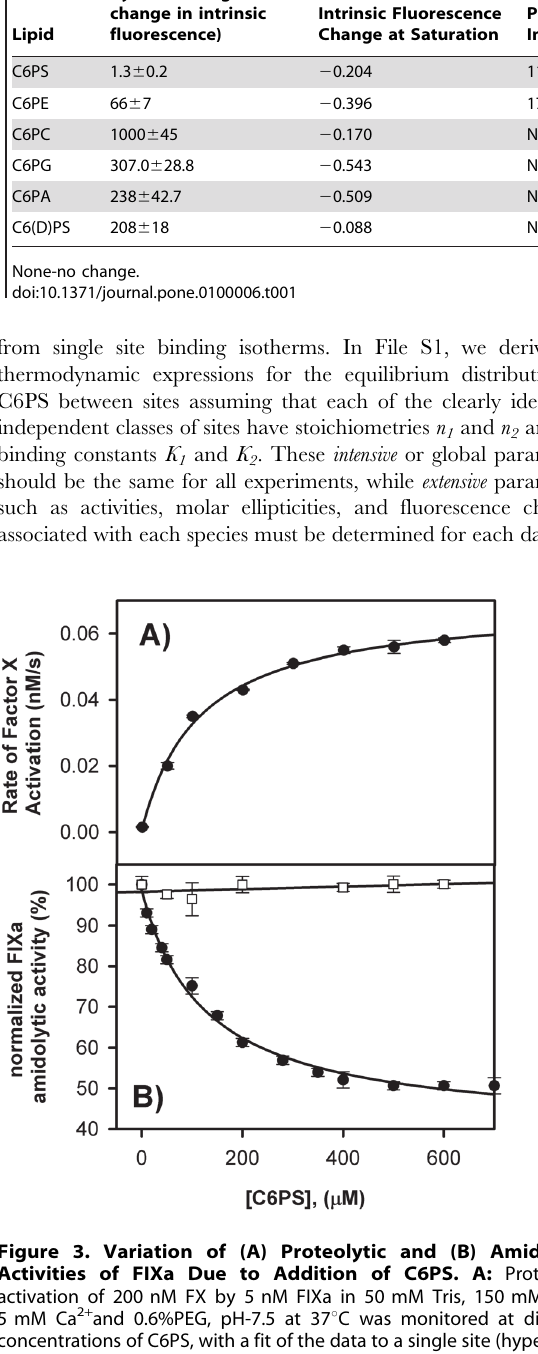
Kd, m M (determined by monitoring Lipid